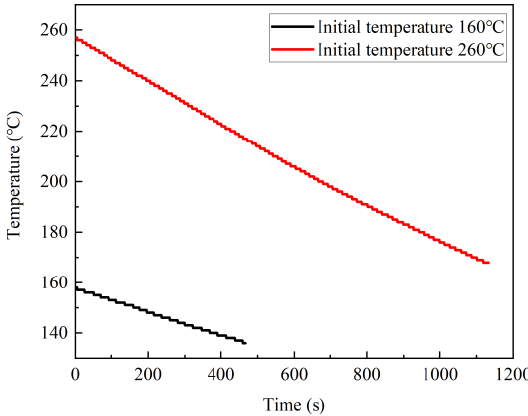
Figure 8. Oil shale temperature changes with the initial temperatures of 160 °C and 260 °C.